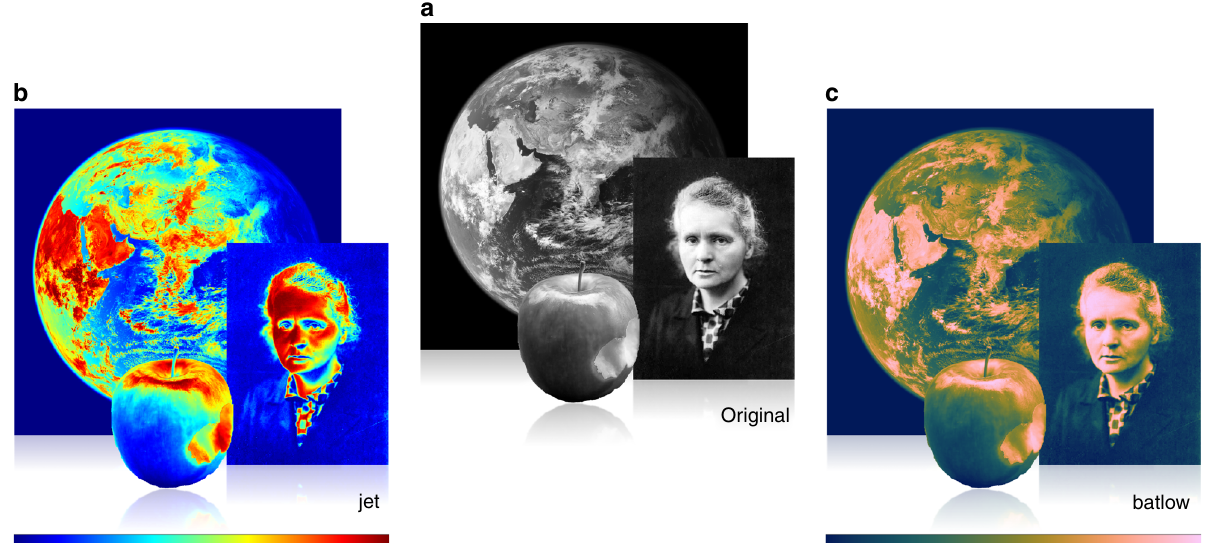
Fig. 1 The superiority of scienti fi cally derived colour maps. By knowing what something looks like in advance, the distortion by unscienti fi c colour maps, like jet or rainbow, becomes instantly obvious. The look of scienti fi c data is, however, usually unknown a priori, which makes the distortion of an unscienti fi c colour map, and the true data representation of a scienti fi cally derived colour map, like batlow 41 , less apparent. Marie Sk ł odowska-Curie, as originally photographed by Henri Manuel around 1920, the Earth from space, and an apple are shown a in their original images and b in distorted and c in undistorted colour versions. Inferring the true picture from an unscienti fi cally (e.g., jet) coloured data set is incomparably harder than from a data set represented in a perceptually uniform and ordered colour map, like batlow 41 .